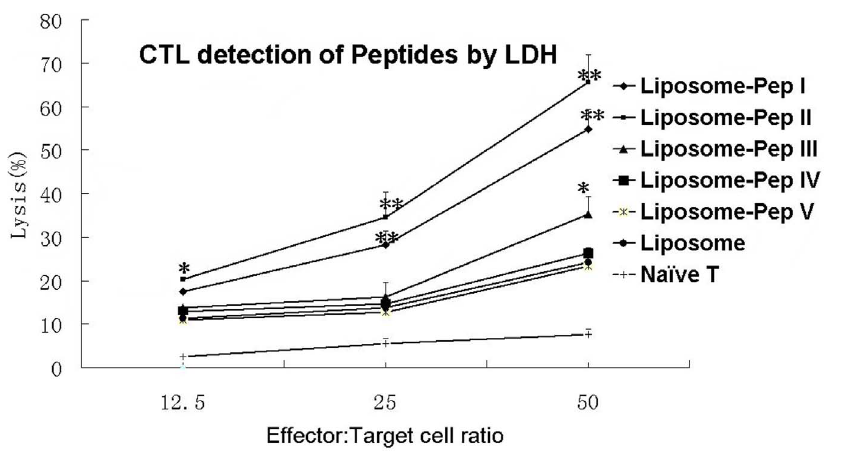
Figure 4. Detection of peptide cytotoxicity by LDH. Spleen T cells isolated and collected from five mice per group that had been injected with peptides, liposome or PBS after boost immunization in week 11 were induced in vitro for 7 days with the corresponding peptides. T cells derived from the peptide I and peptide II groups had significantly higher cytotoxic activity compared to liposome. Peptide III and unrelated peptide IV-V did not show any significant difference in cytotoxic activity compared to the liposome. ** P , 0.01, * P , 0.05 vs. control Liposome mice.